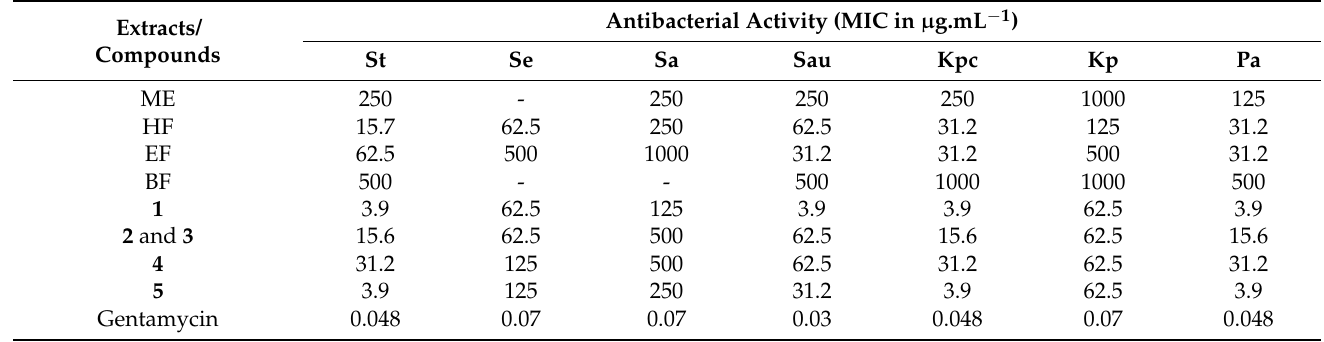
Table 4. Antibacterial activity of extract, fractions, and compounds (MIC in µ g.mL − 1